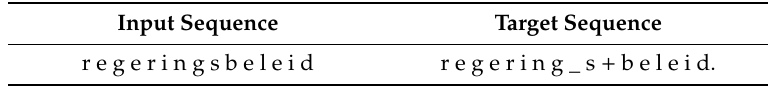
Table 3. Input and Target format for the compound analysis model for the word “regeringsbeleid” (“government